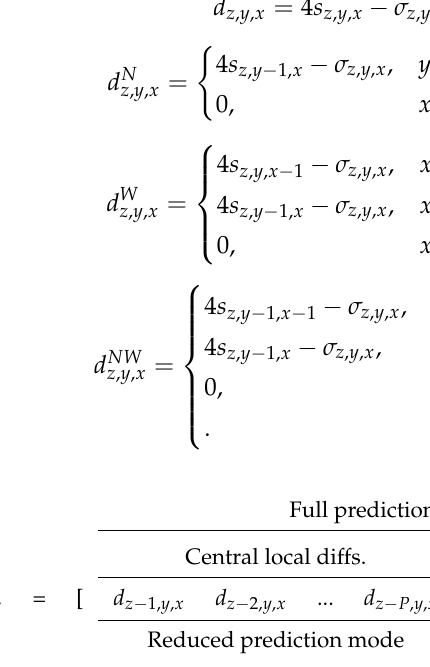
Figure 2. Construction of the local differences vector U z , y , x